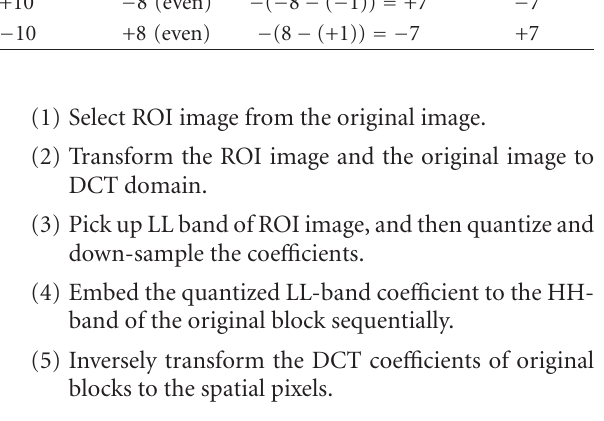
Table 2: Example for f ( m , n )